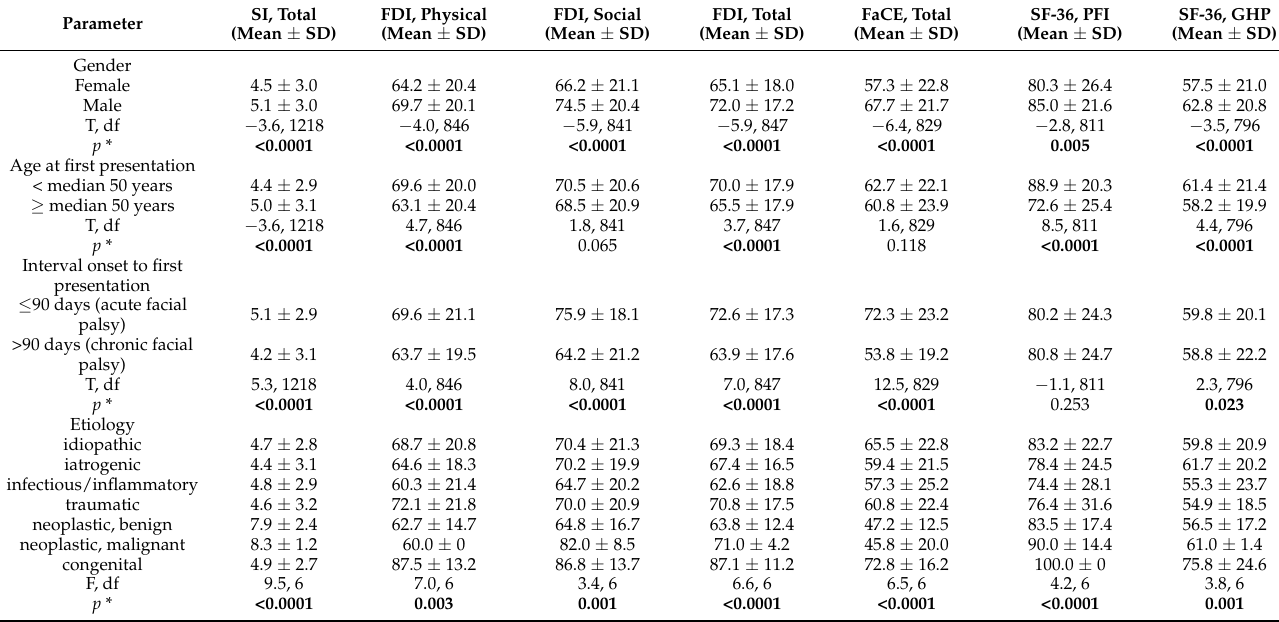
Table 4. Initial facial function of patients by demographics and etiology.